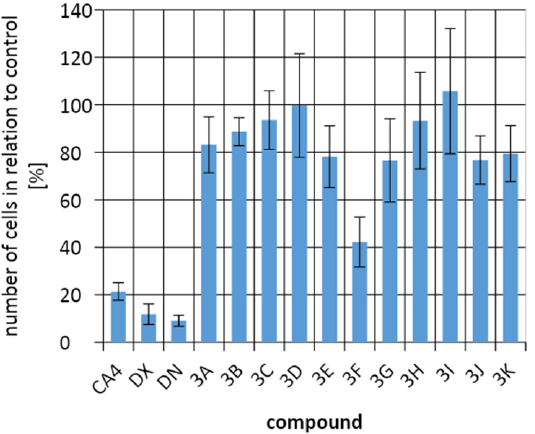
Figure 10. Comparing the number of cells from line B16F10 in relation to the control culture.